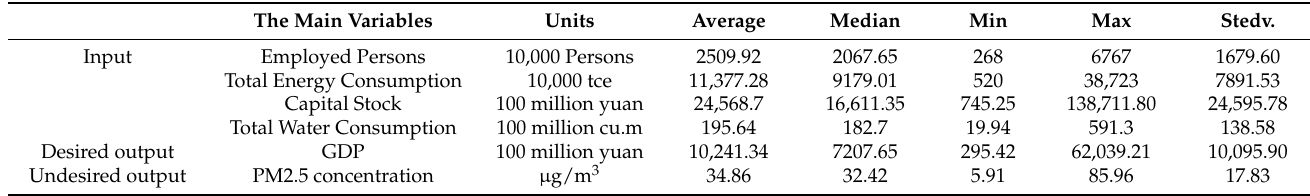
Table 1. Statistical descriptions of the variables.